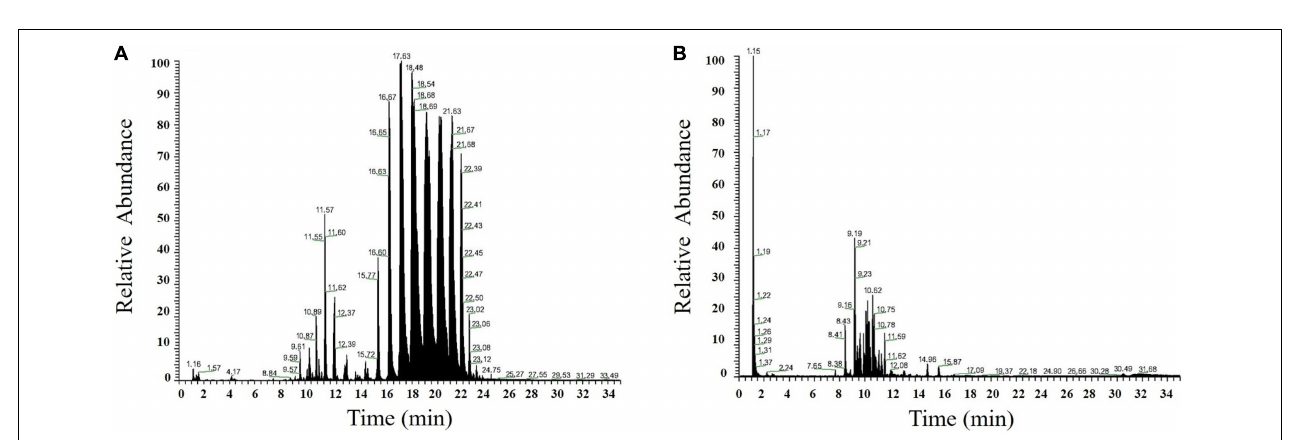
FIGURE 1 | Chromatogram in ESI-positive (A) and ESI-negative ion modes (B) .